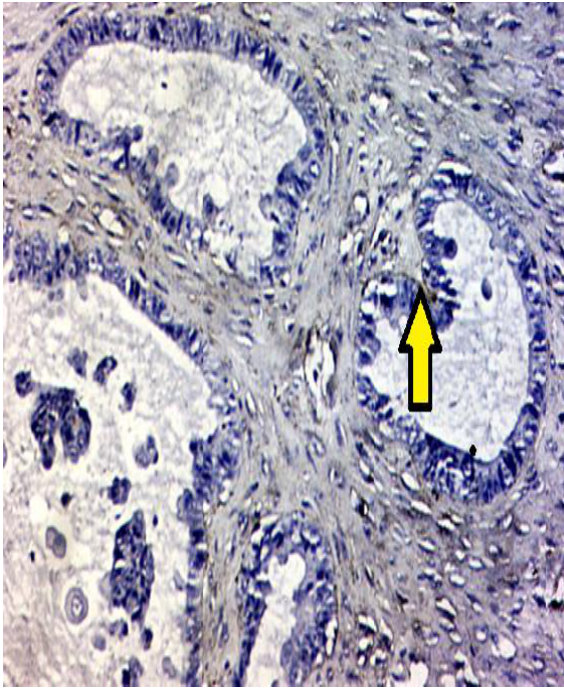
Figure 3: Well differentiated mucinous carcinoma stained with anti CD44v6 with positive brown cytoplasmic and cell membrane with scoring index 3, (40X).